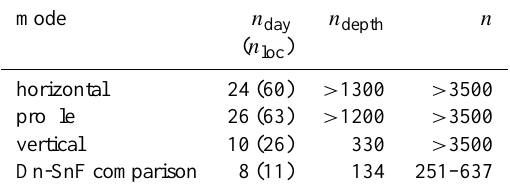
Fig. 7. a) Box-plot comparing estimated liquid water content (mWC) and water content measured with the Snow Fork ( θ SnF , n=318, 4 observers). As comparison the mean for each class is shown based on the conversion given in Fierz et al. (2009). b) shows the frequency that mWC was correctly estimated (light blue bars). For comparison, data by a previous study is shown (black dashed line, black squares Martinec, 1991b, n=518, 9 observers). θ SnF is corrected by -0.8 vol.% (this corresponds to the median offset in dry snow).